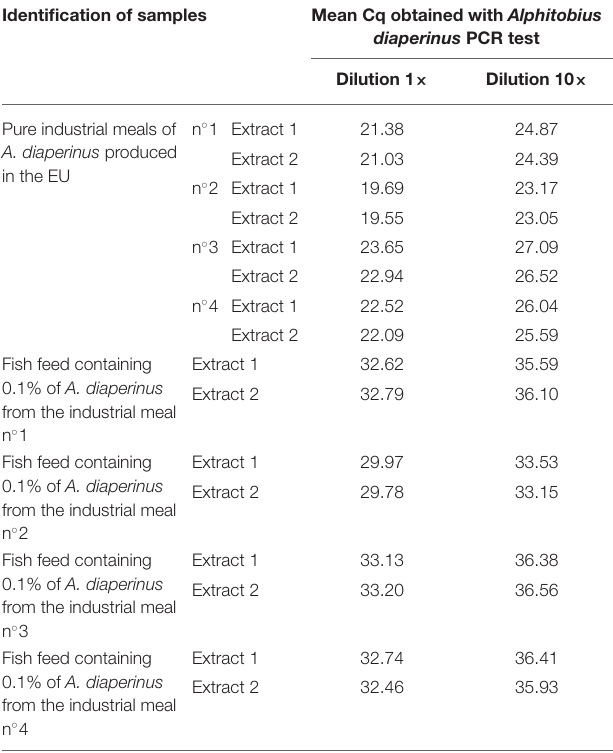
TABLE 9 | Mean Cq obtained with the Alphitobius diaperinus PCR test on processed samples from A. diaperinus and on mixes containing 0.1% in mass fraction of A. diaperinus in a commercial fish feed ( n = 2).